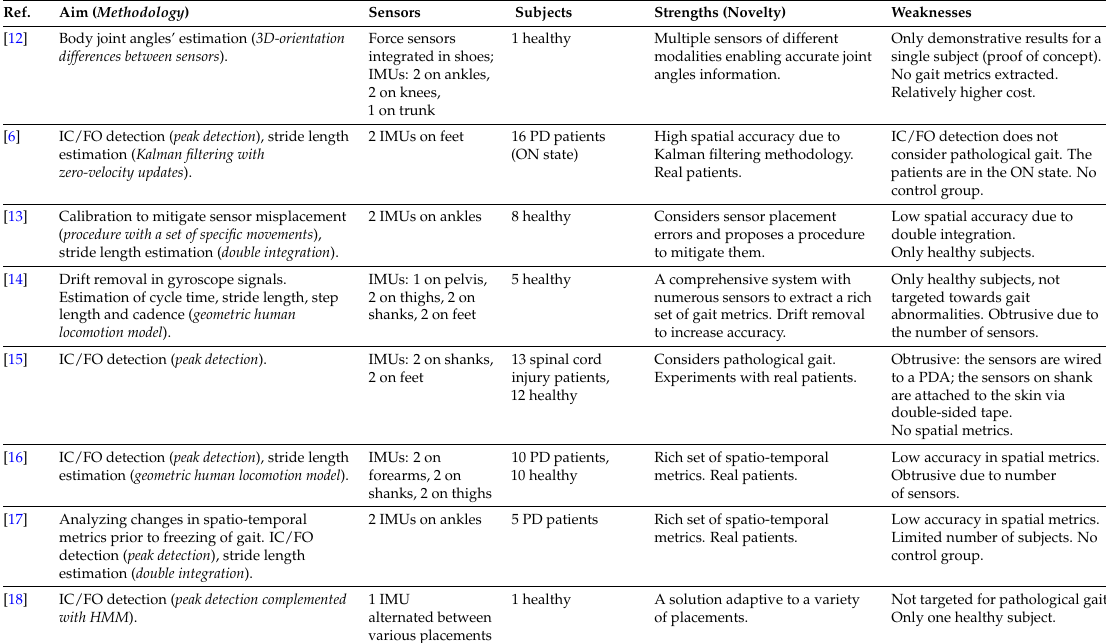
Table 2. Related work on gait analysis with